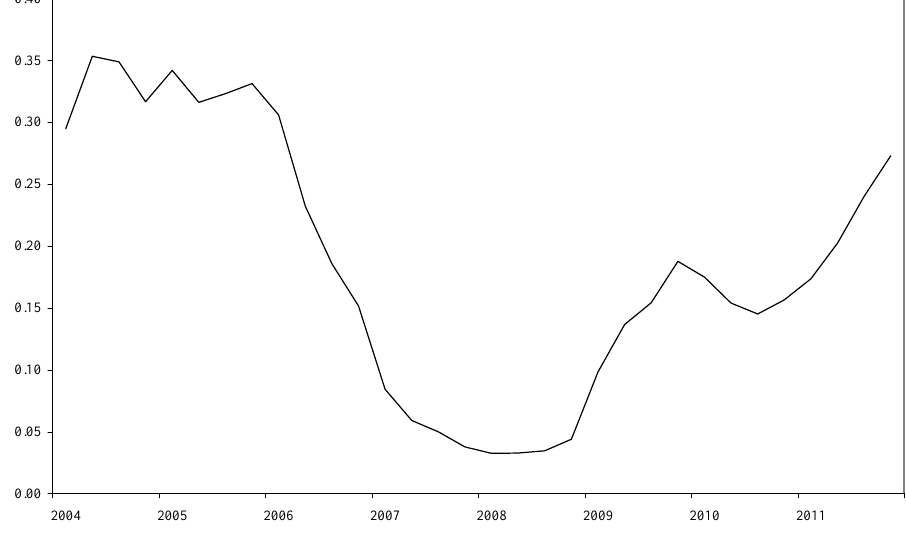
Figure 3. Standard deviation of the bivariate correlations of the cycles of the member states with the euro area cycle, for a 4-year rolling